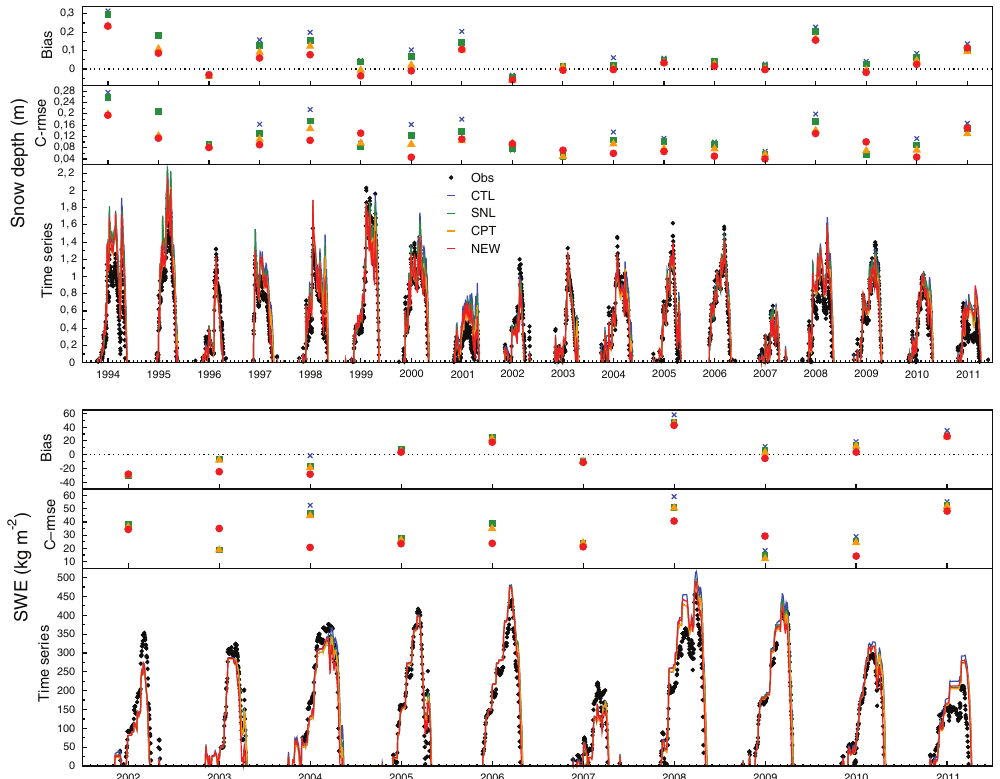
Figure 3. Overview of the four experiments performed at the Col de Porte field site. Daily simulated and observed data for snow depth (top panel) and SWE (bottom panel) are provided for 18 and 10 years respectively. In situ observations are in black, the CTL simulation in blue, SNL in green, CPT in orange, and NEW in red. The corresponding statistics are given in terms of annual bias and c-rmse for each year by measurements